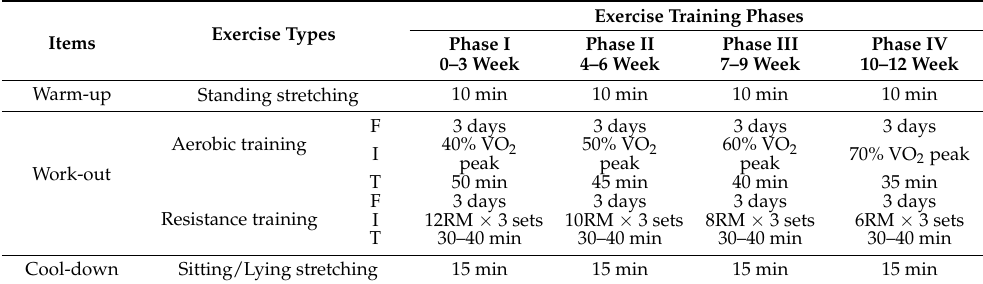
Table 1. The exercise training programs for ovarian cancer